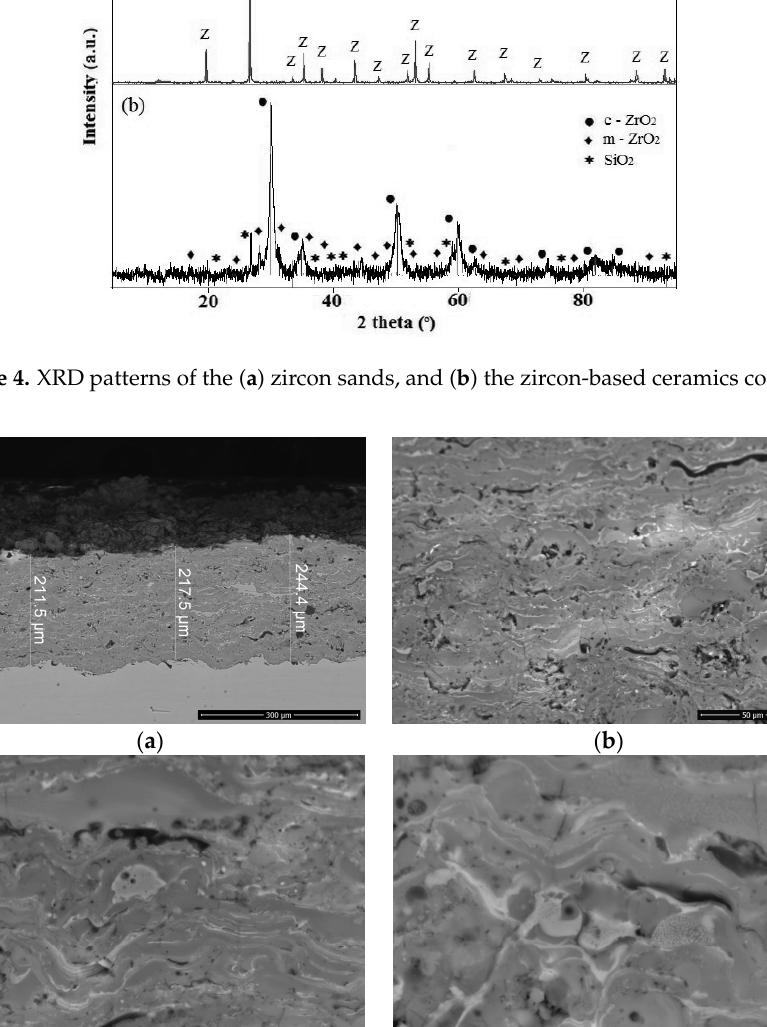
Figure 5. SEM micrographs of cross-sections of the zircon-based ceramics coating (back-scattered electron mode). ( a ) ×500, ( b ) ×2000, ( c ) ×5000, and ( d ) ×10000.